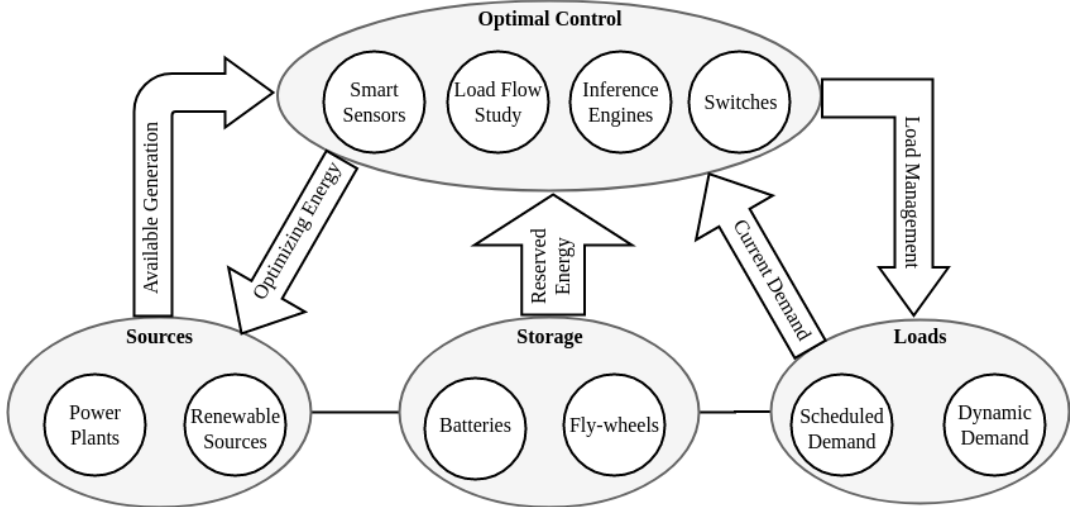
Figure 1. General sketch of the energy management system for the optimal allocation of resources in accordance with the network